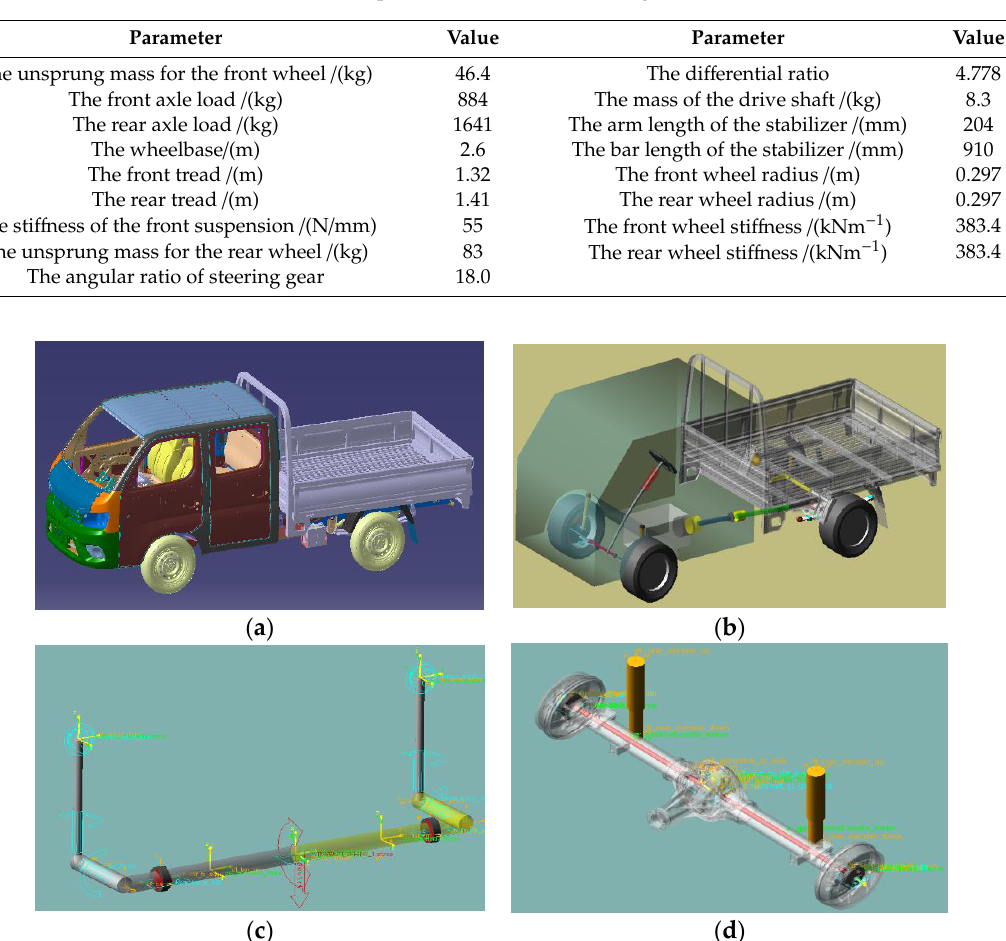
Figure 7. The light truck models: ( a ) The geometric model, ( b ) the dynamic model, ( c ) the sub-model of the stabilizer system, and ( d ) the sub-model of the rear axle with dampers.